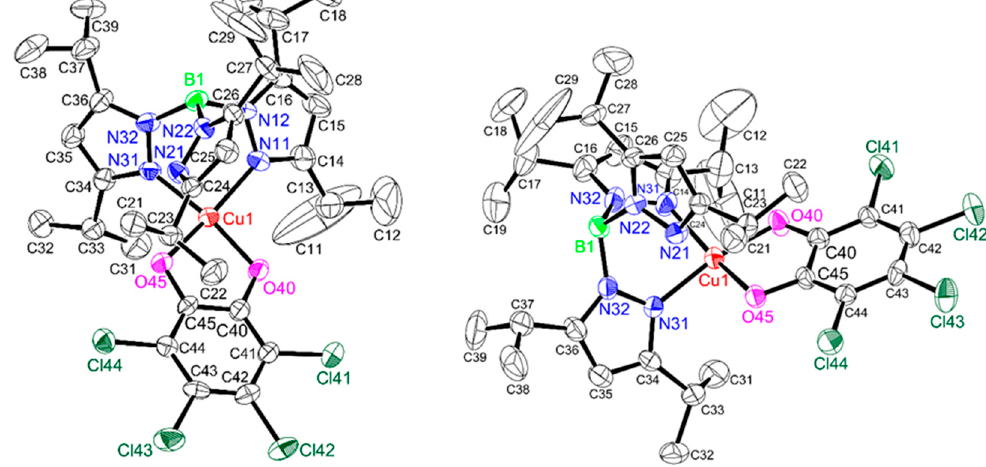
Figure 2. Crystal structure of [Cu(catCl 4 )(L1H)] showing 50% displacement ellipsoids and the atom labeling scheme ( left : top view, right : side view). Hydrogen atoms were omitted for reasons of clarity. Relevant bond lengths (Å) and angles (°): Cu1–N11, 1.976(5); Cu1–N31, 1.973(5); Cu1–O40, 1.890(4);